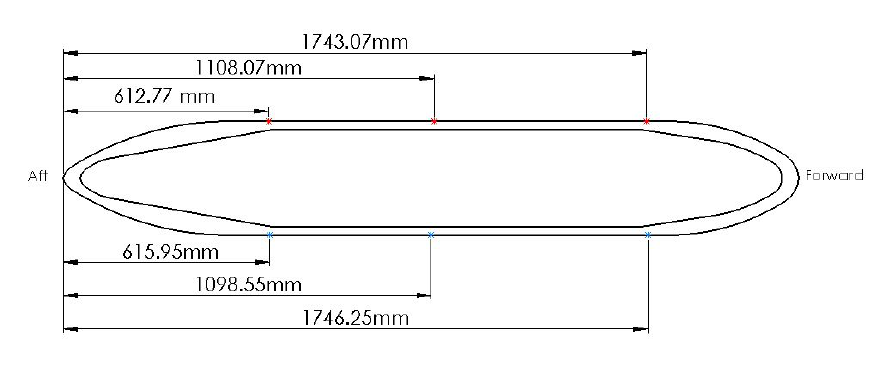
Figure A2. Measuring Locations.